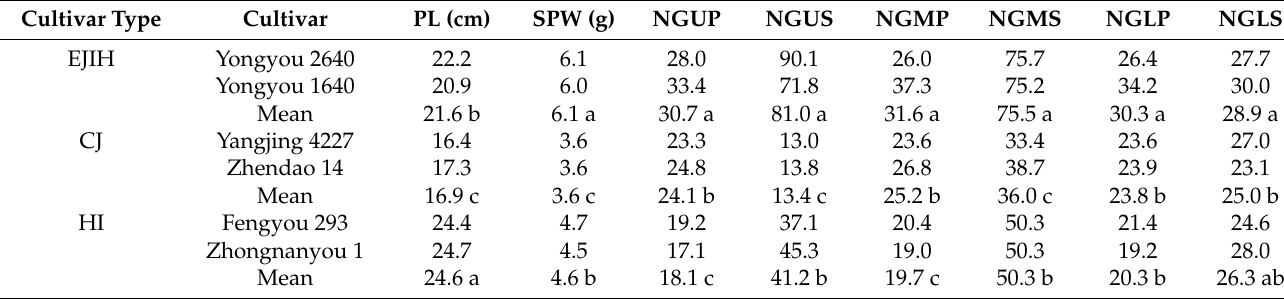
Table 5. Panicle traits of rice